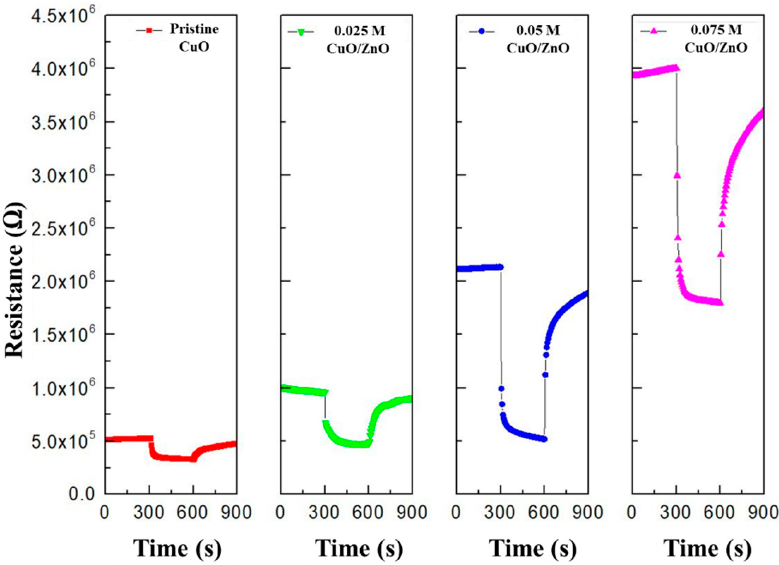
Figure 8. Resistance of the pristine CuO, 0.025 M CuO/ZnO, 0.05 M CuO/ZnO, and 0.075 M CuO/ZnO to 100 ppm NO 2 .